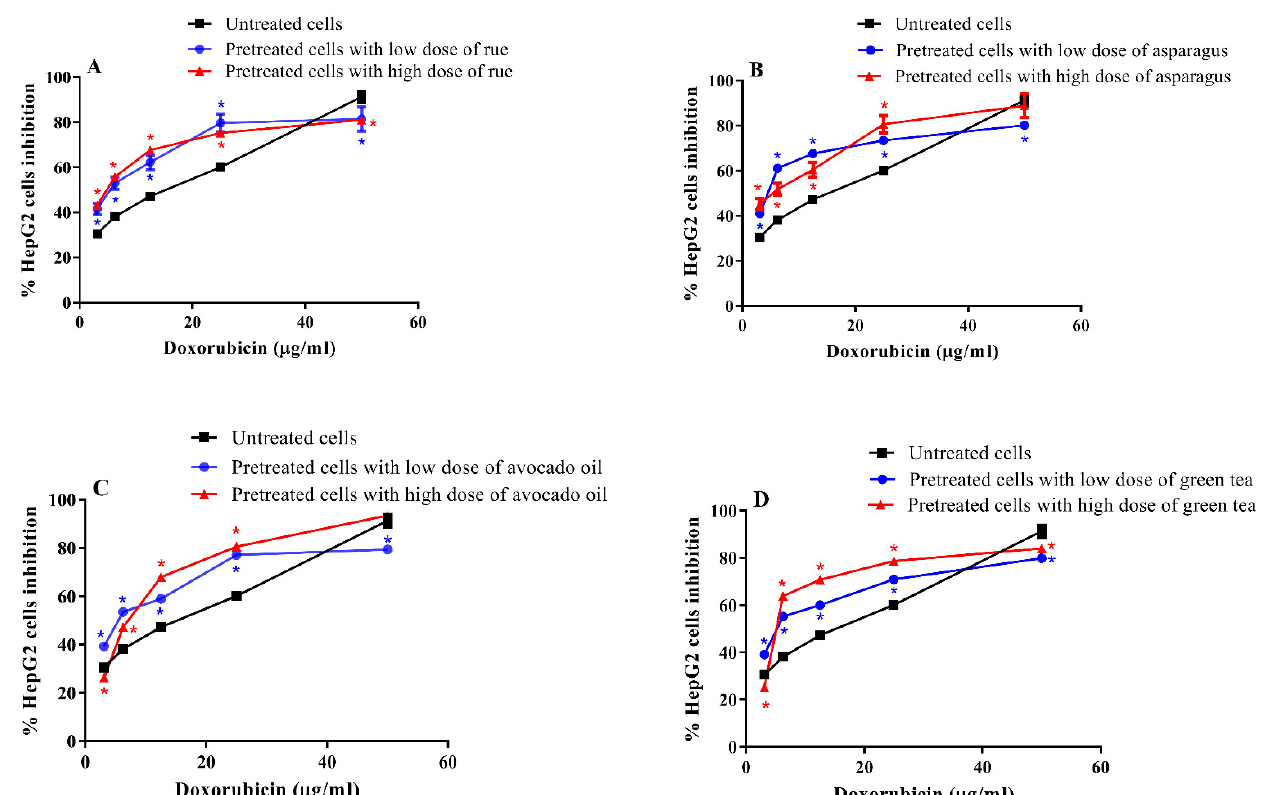
Figure 3. MTT assay of doxorubicin using untreated and plant extract-pretreated HepG2 cells. Doxorubicin IC 50 was determined using untreated HepG2 cells vs. HepG2 cells pretreated with ( A ) rue in doses of 8.62 (IC 20 ) and 12.08 (IC 35 ) µ g/mL, ( B ) asparagus in doses of 11.62 (IC 20 ) and 18.08 (IC 35 ) µ g/mL, ( C ) avocado oil in doses of 44.56 (IC 20 ) and 71.52 (IC 35 ) µ g/mL, or ( D ) green tea in doses of 55.58 (IC 20 ) and 90.92 (IC 35 ) µ g/mL. Data are presented as means ± S.D. ( n = 3) as compared with the corresponding doxorubicin concentration in the untreated HepG2 cells (*) using unpaired Student’s t -test at p <